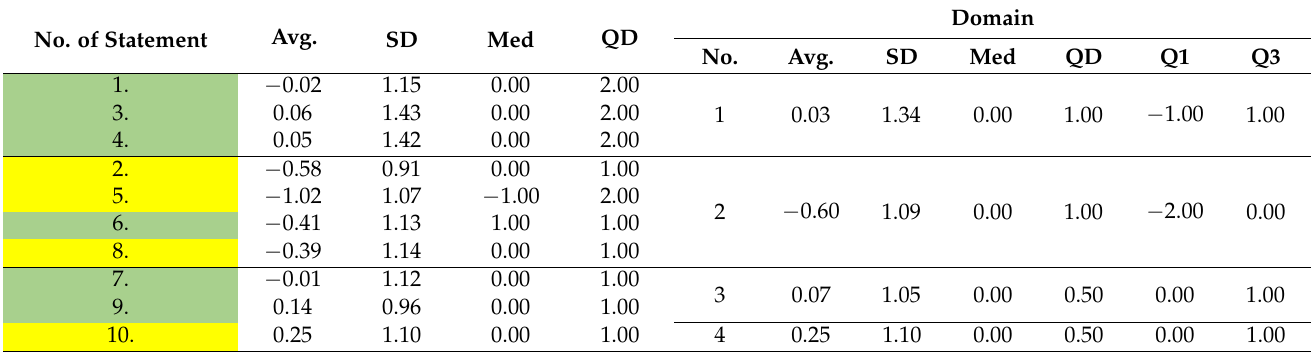
Table 5. Averages and dispersion measures for scale questions and the proposed